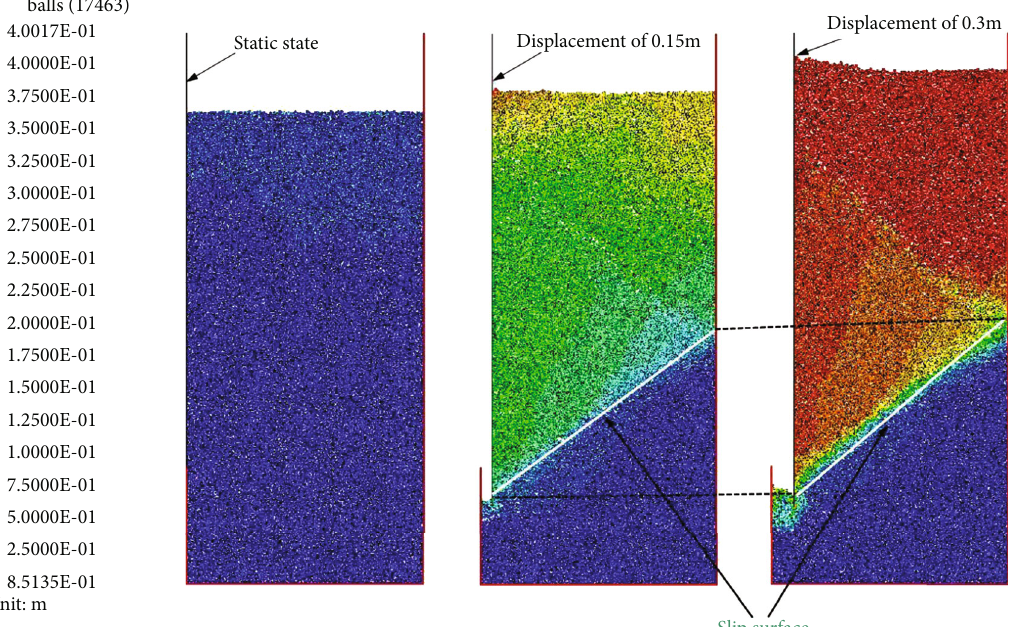
Figure 9: Variation of soil displacement fi eld behind retaining